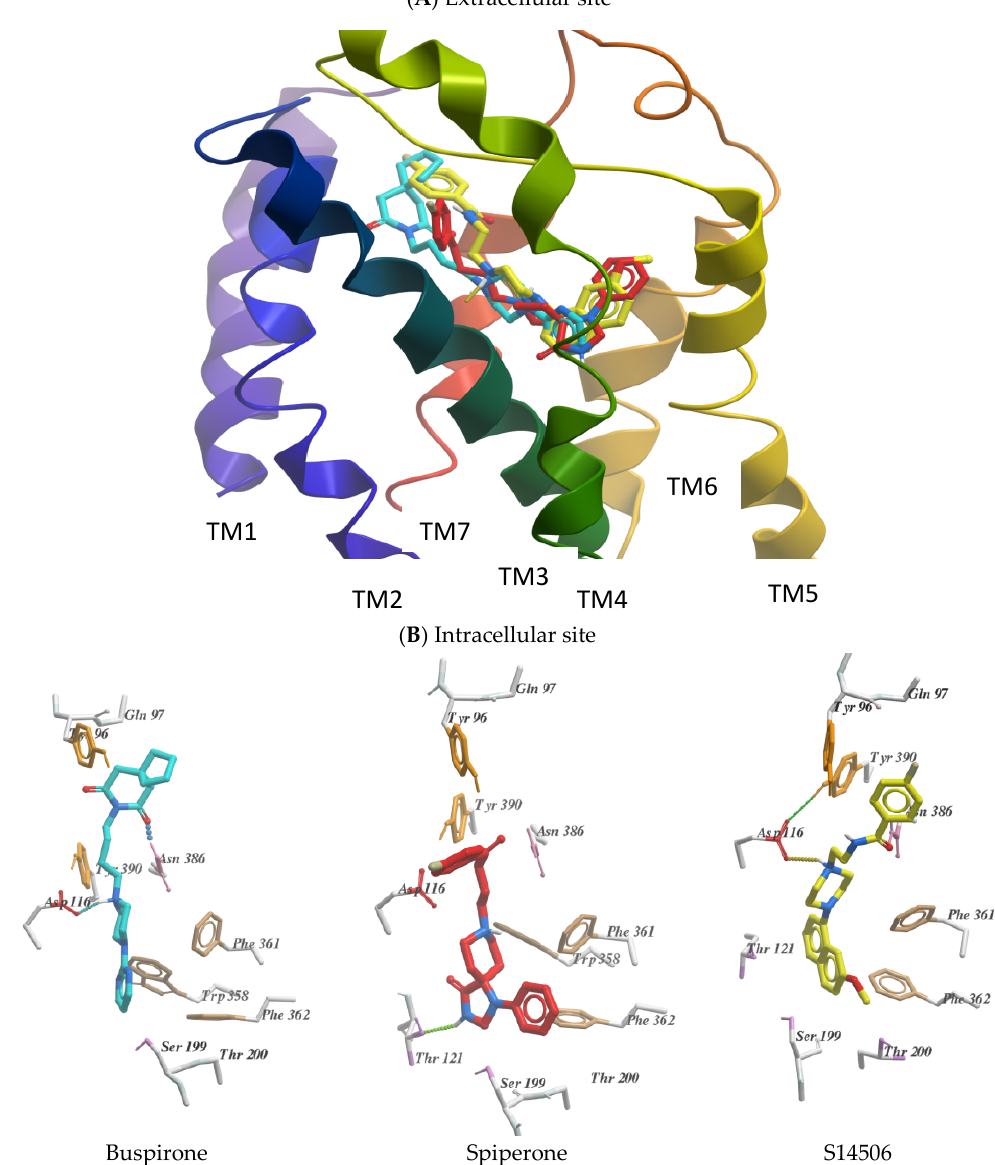
Figure 11. ( A ) The binding pose of S14506 (yellow), buspirone (cyan) and spiperone (red) in the 5HT 1A receptor model (colored from N -terminal (violet) to C-terminal (red)) and main interactions in the binding pocket of the 5-HT 1A receptor; ( B ) interaction of S14506, buspirone and spiperone with the residues in the 5-HT 1A binding pocket.